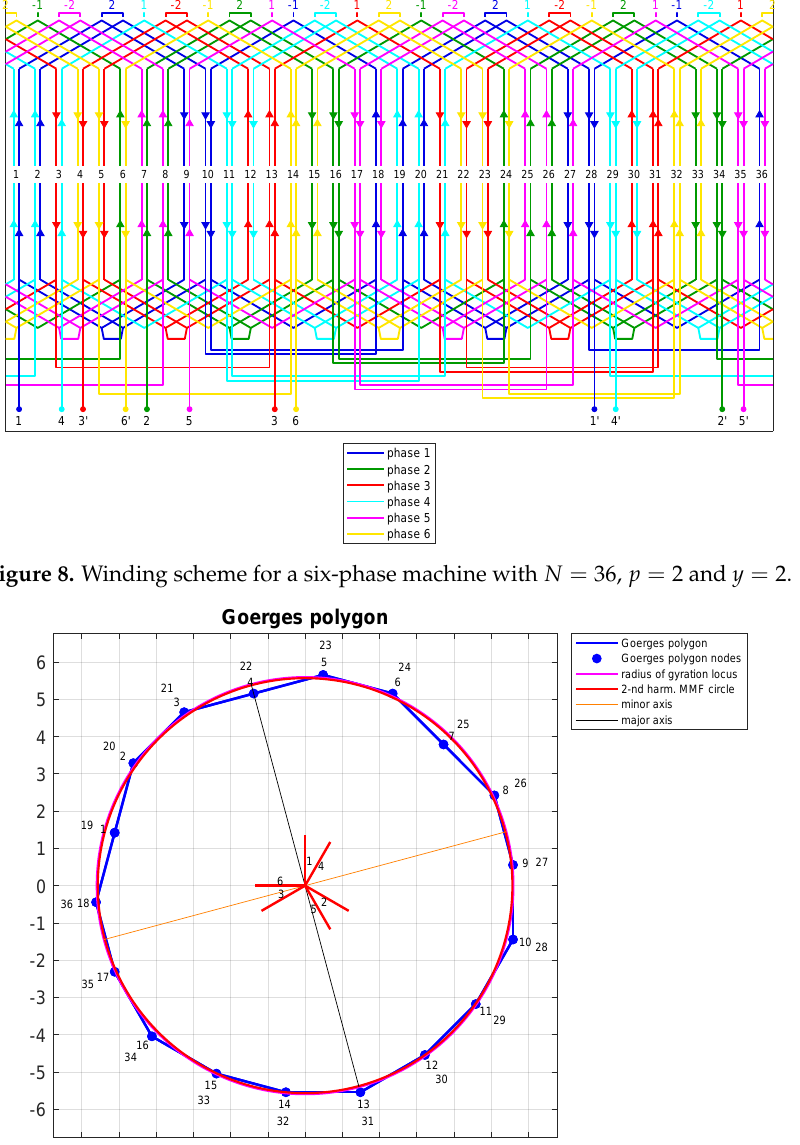
Figure 7. Spatial MMF distribution for a five-phase machine with N = 45, p = 5 and y = 2. Winding with 1 path.